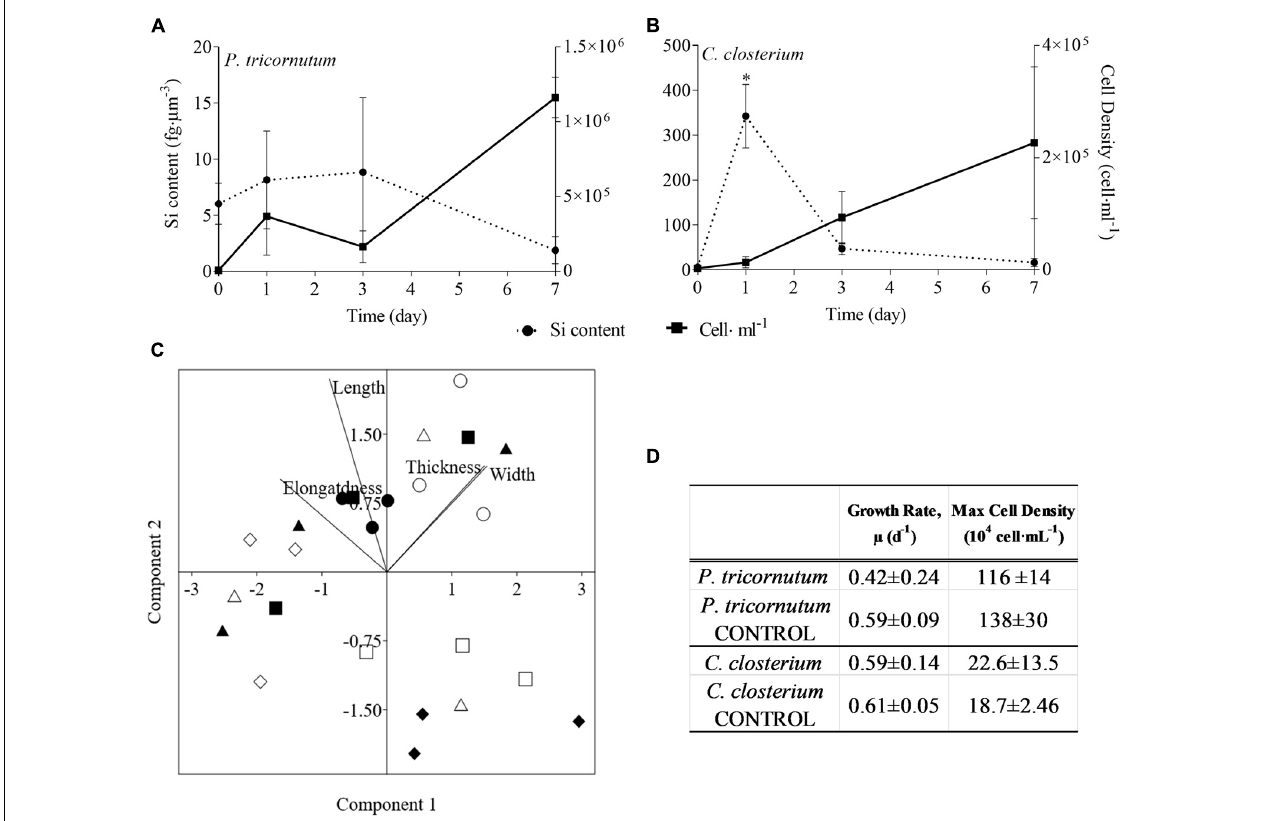
FIGURE 2 | (A,B) Si content (fg µ m − 3 ; dashed line) and cell density (cell ml − 1 ; solid line) in the two pennate diatom species under copepods exposure. Data are means of 3 biological replicas. Error bars show SD while asterisks indicate significant differences in Si content of each species among days according to one-way ANOVA followed by Tukey’s post-hoc test, p < 0.05 (details in Supplementary Table 11 ). (C) PCA analysis on morphological characteristics of pennate diatoms ( C. closterium and P.tricornutum ) in monospecifc cultures. Different symbols indicate different time points during the experiment: T0 ◦• ; T1 (cid:3)(cid:4) , T3 (cid:52) (cid:78) , T7 ♦(cid:7) , while different colours indicate different species: black for P. tricornutum , white for C. closterium . (D) Comparison of growth rates (d − 1 ) and maximum cell densities (cells · mL − 1 ) for each of the two diatom species between cultures with and without (CONTROL) copepods. The values are means of 3 biological replicas ± SD. For each species, asterisks indicate when growth rate or max cell density were statistically different between diatoms exposed or not (CONTROL) to copepods as determined by unpaired t test, p < 0.05 ( Supplementary Table 11